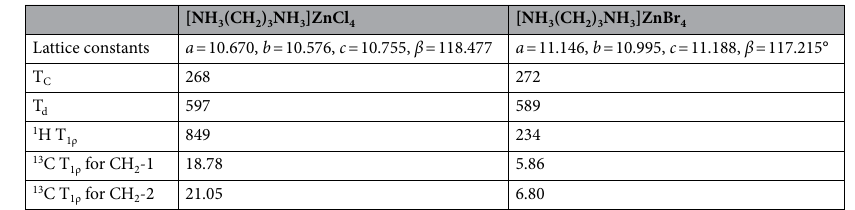
Table 1. The lattice constants (Å), phase transition temperatures T C (K), thermal decomposition temperatures T d (K), and spin–lattice relaxation times T 1ρ ( ms ) in [NH 3 (CH 2 ) 3 NH 3 ]Zn X 4 ( X = Cl and Br) crystals at 300